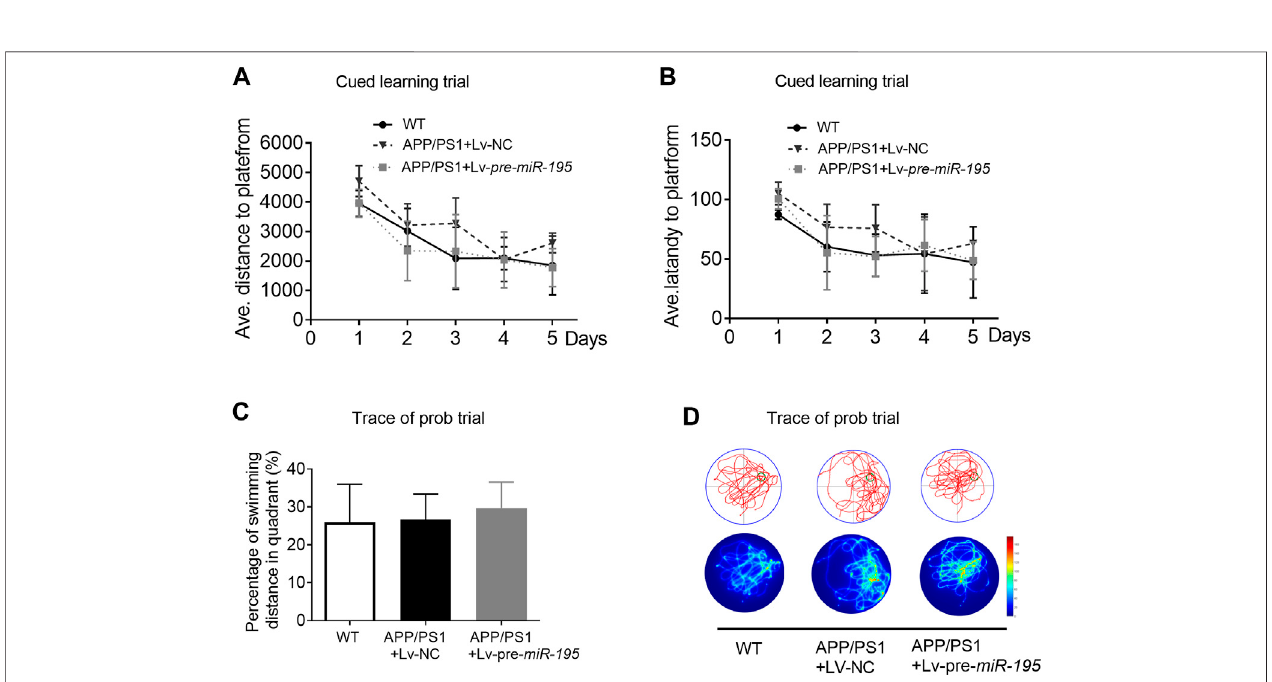
FIGURE 3 | APP/PS1 mice at the age of 5M-old showed no signi fi cant spatial learning de fi cits (A) Average distance to platform after Lv-pre -miR-195 injection for 1M. n (cid:2) 6 for WT, Lv-NC and Lv-pre -miR-195 group (B) Average escape latency to platform after treatment of Lv- pre-miR-195 for 1M. n (cid:2) 6 for WT, APP/PS1 and Lv- pre -miR-195 group (C) Percentage of swimming distance in the target quadrant relative to the total distance of the pool during probe trial. n (cid:2) 6 for WT, Lv-NC and Lv- pre -miR-195 group (D) Representative path tracings and heat maps of the probe test on day 6 in the MWM test for each group.